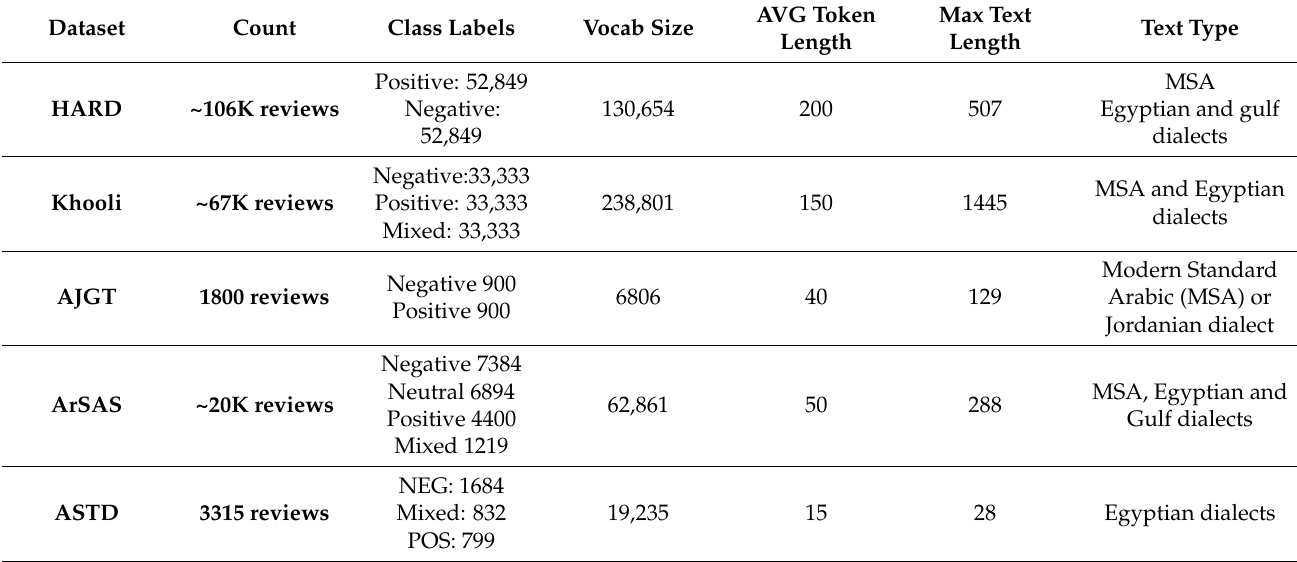
Table 2. Summarization of datasets.